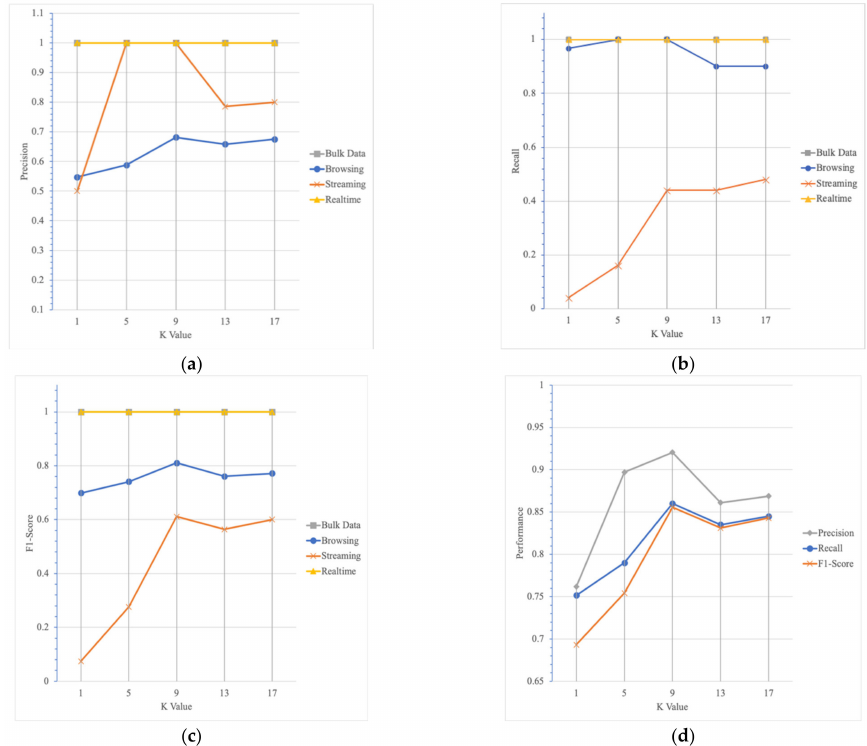
Figure 13. Results of majority voting method ( a ) accuracy of each category, ( b ) recall rate of each category, ( c ) F1-Score of each category, and ( d ) average of each category index.